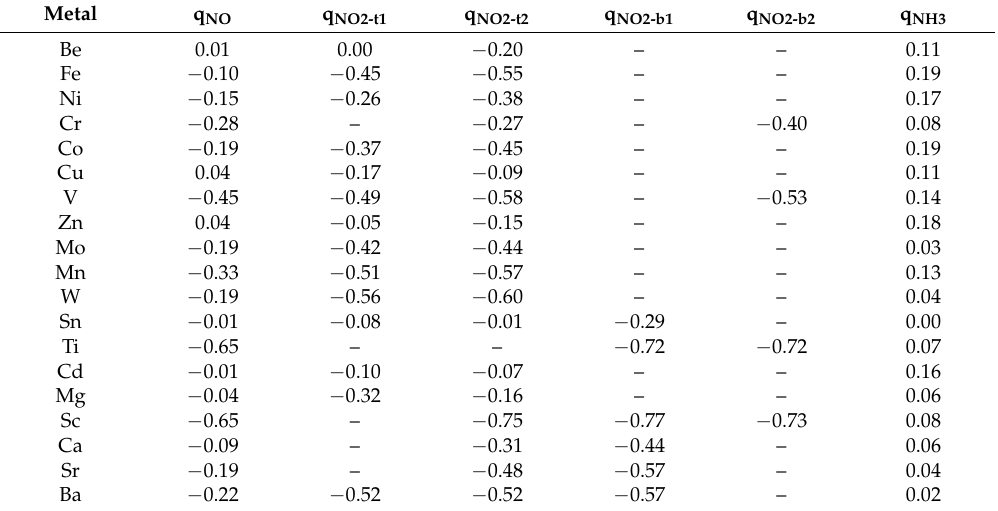
Table 4. Bader charge q x (x = NO, NO 2 -t1, NO 2 -t2, NO 2 -b1, NO 2 -b2, and NH 3 ) for NCCs on M-HKUST-1 (The charges are shown for the entire NCCs molecule).